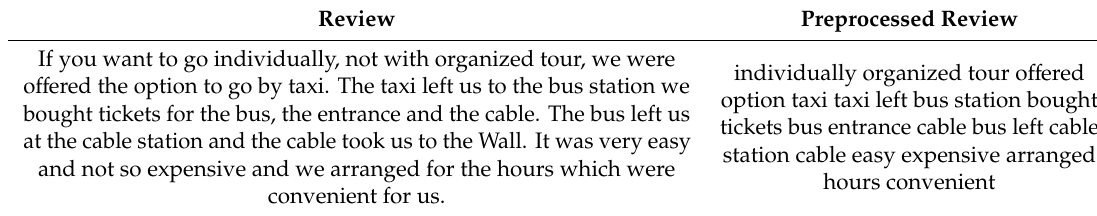
Table 3. Review and preprocessed results.